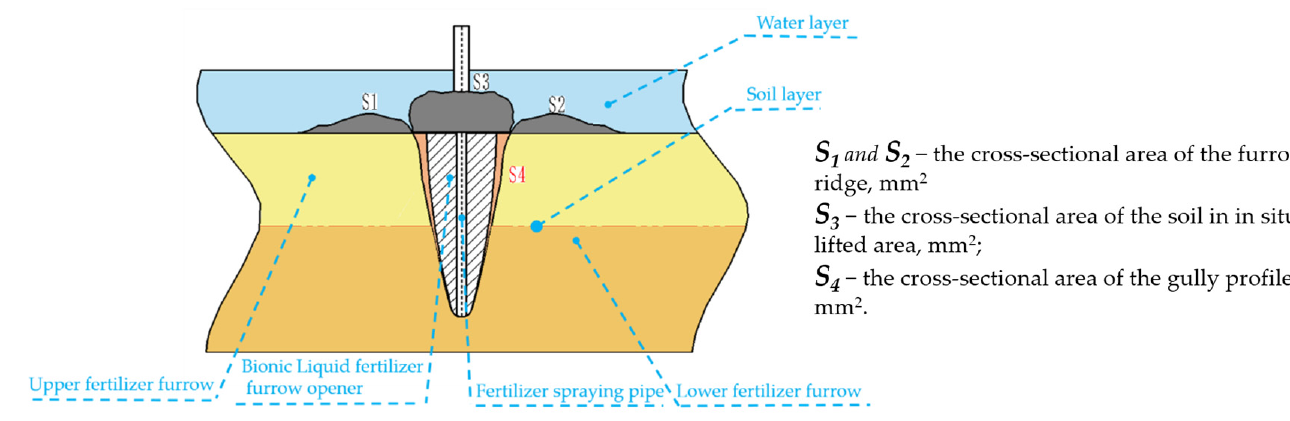
Figure 10. Schematic diagram of soil disturbance.